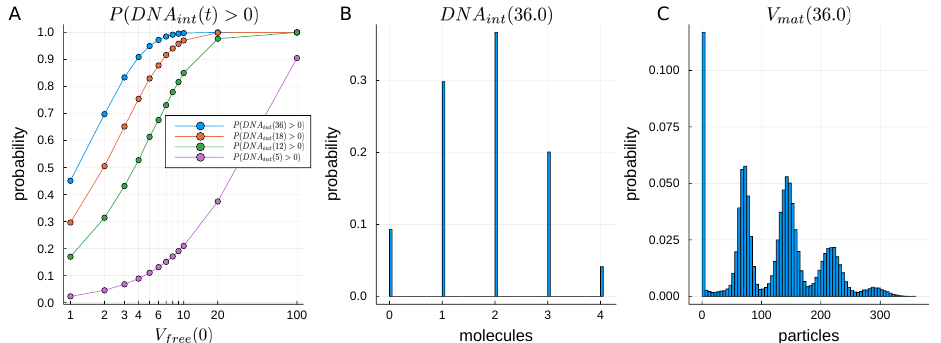
Figure 3. Probability of cell infection (i.e., integration of at least one proviral DNA molecule [ DNA int ] ) at a certain time as a function of the initial number of free virions [ V free ]( 0 ) ( A ). Histograms of number of integrated proviral DNA molecules [ DNA int ] ( B ), number of released matured virions [ V mat ] ( C ) at t = 36 h for initial condition [ V free ]( 0 ) =